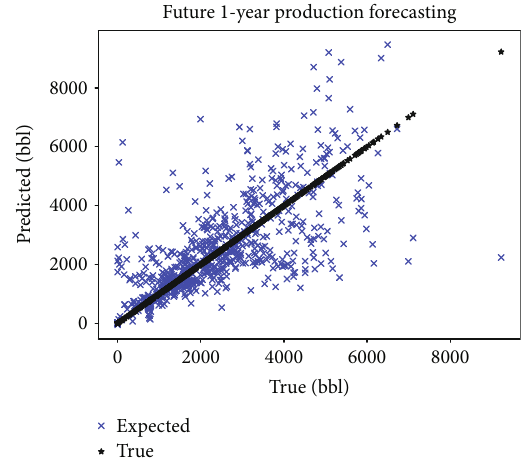
Figure 2: 1-year oil rate prediction of the DNN system in Bakken